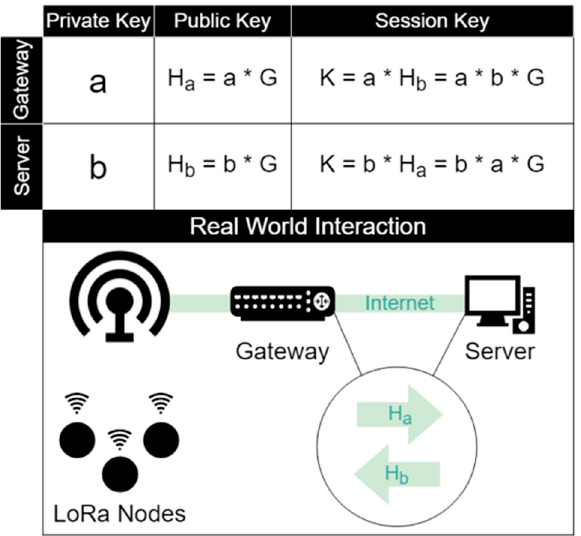
Figure 10. ECDH being used between a LoRA gateway and the cloud application server.